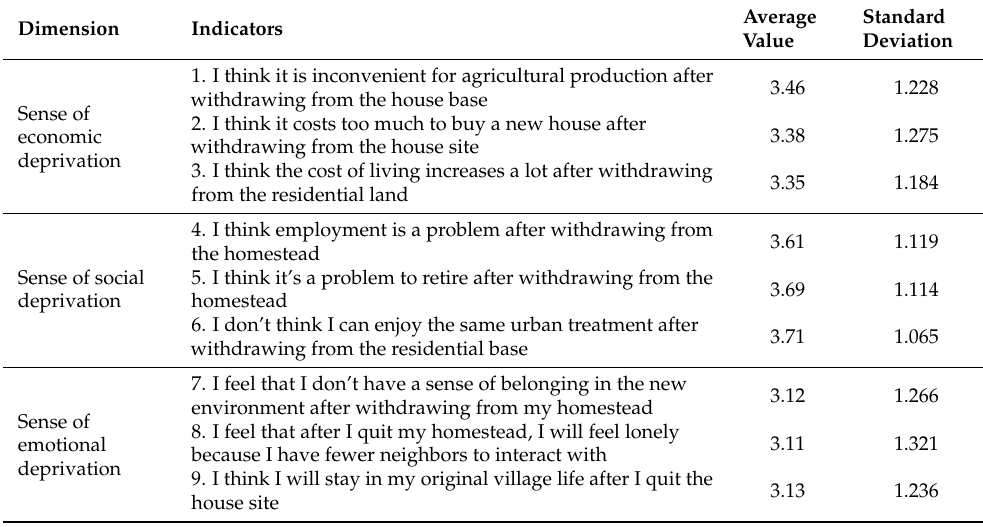
Table 1. Relative deprivation evaluation index.